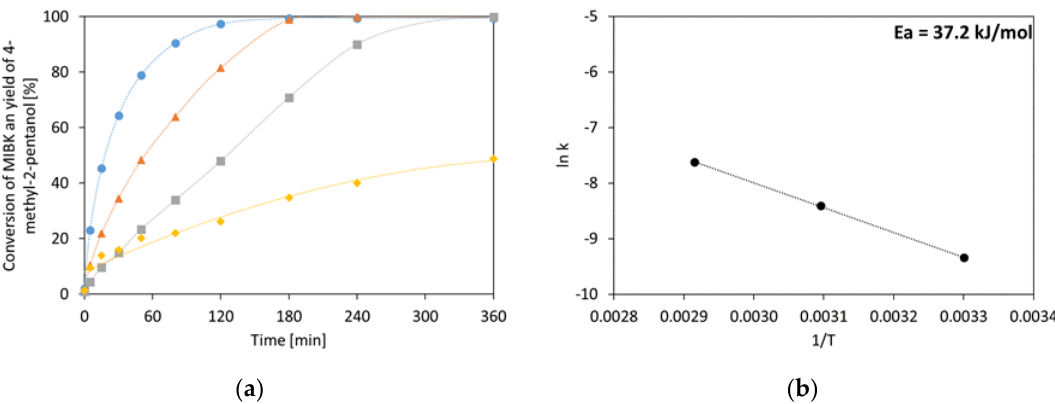
Figure 4. ( a ) Conversion of MIBK and yield of 4-methyl-2-pentanol and ( b ) Arrhenius plot for experiments at 30, 50, and 70 °C in isopropanol and water mixture at 70 °C.